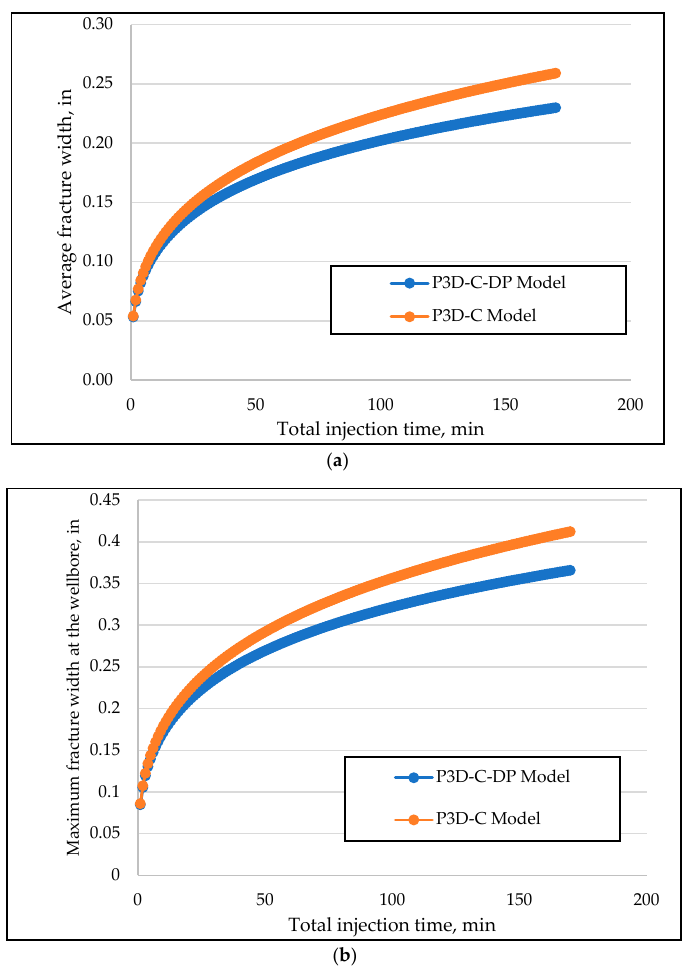
Figure 6. ( a ) Average fracture width versus total injection time for P3D-C and P3D-C-DP models; ( b ) maximum fracture width at the wellbore versus total injection time for P3D-C and P3D-C-DP models.